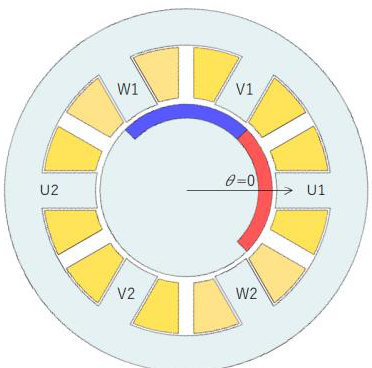
Figure 12. Cross-section of the verification motor structure of the novel consequence-pole PM motor. Table 1. Specifications of a novel consequent-pole PM motor.